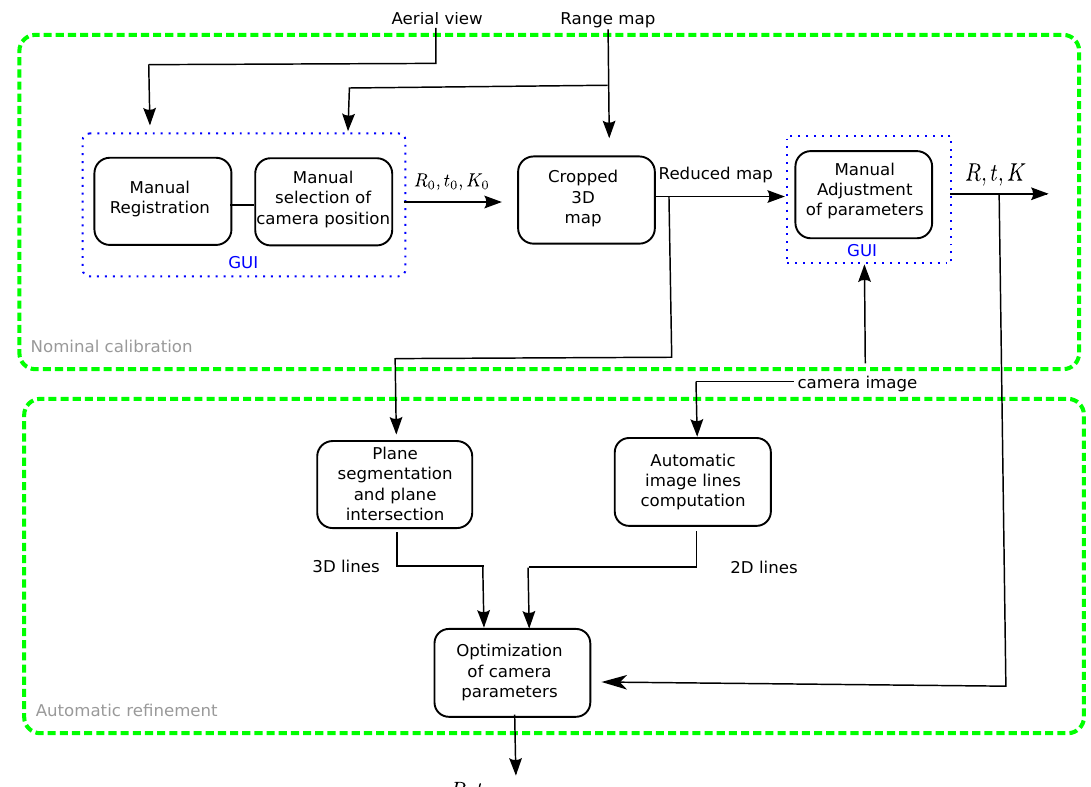
Figure 2. Two-step calibration methodology. In the first step, a graphical user interface is used to assist in an initial manual registration of the point cloud. The second step refines this registration, matching 2D image lines with 3D edges in the point